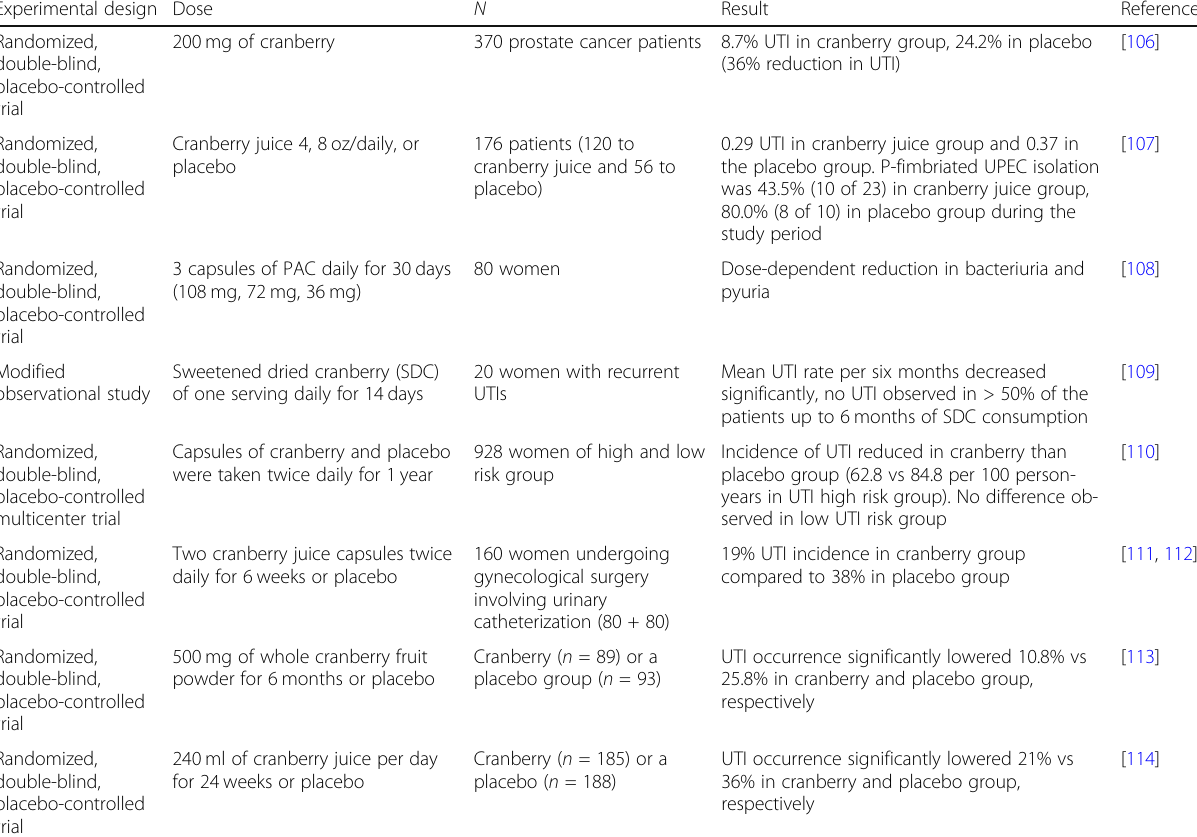
Table 4 Clinical trials of cranberry products for UTI prevention in different populations (Continued) Experimental design